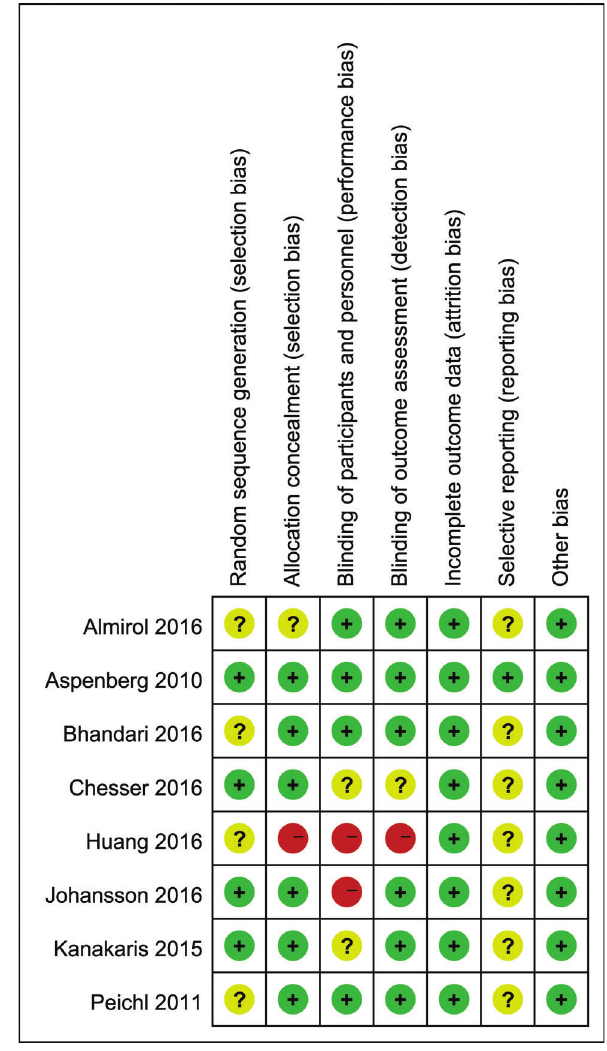
Figure 2 - Risk-of-bias